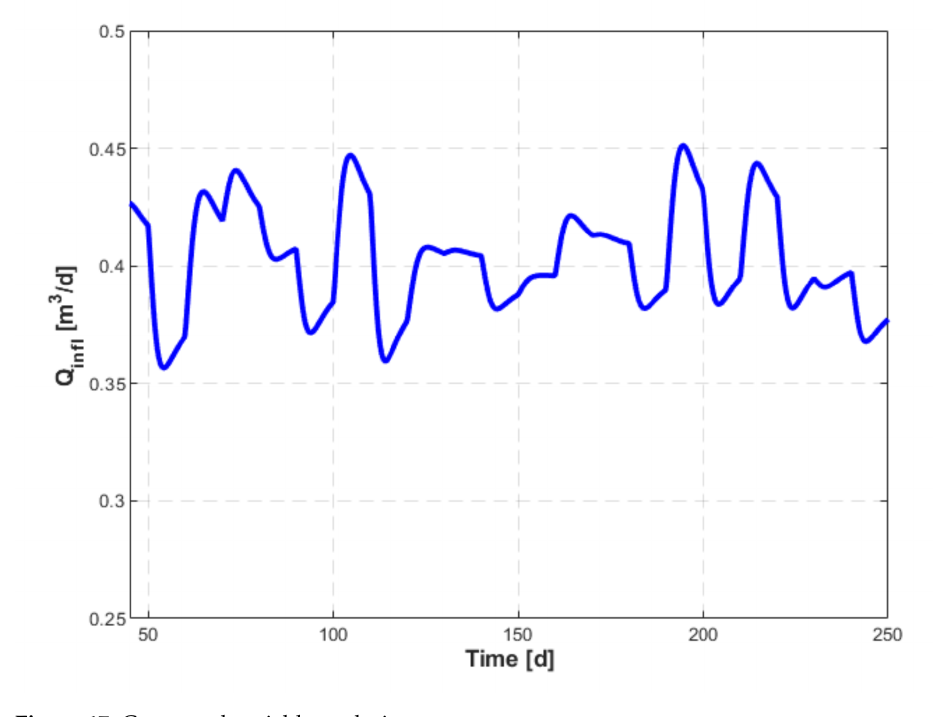
Figure 17. Command variable evolution.